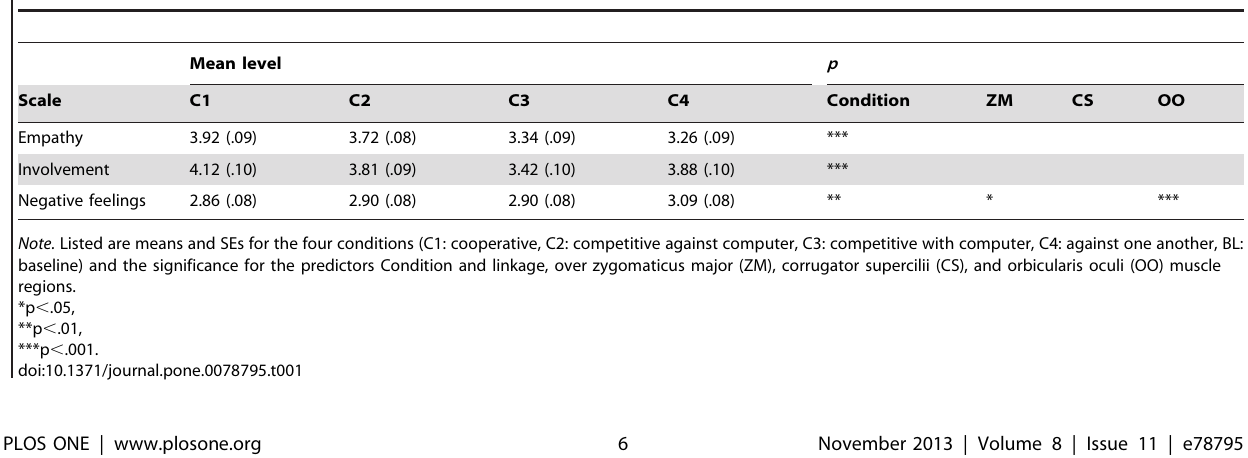
Table 1. Condition and EMG Linkage as Predictors of Social